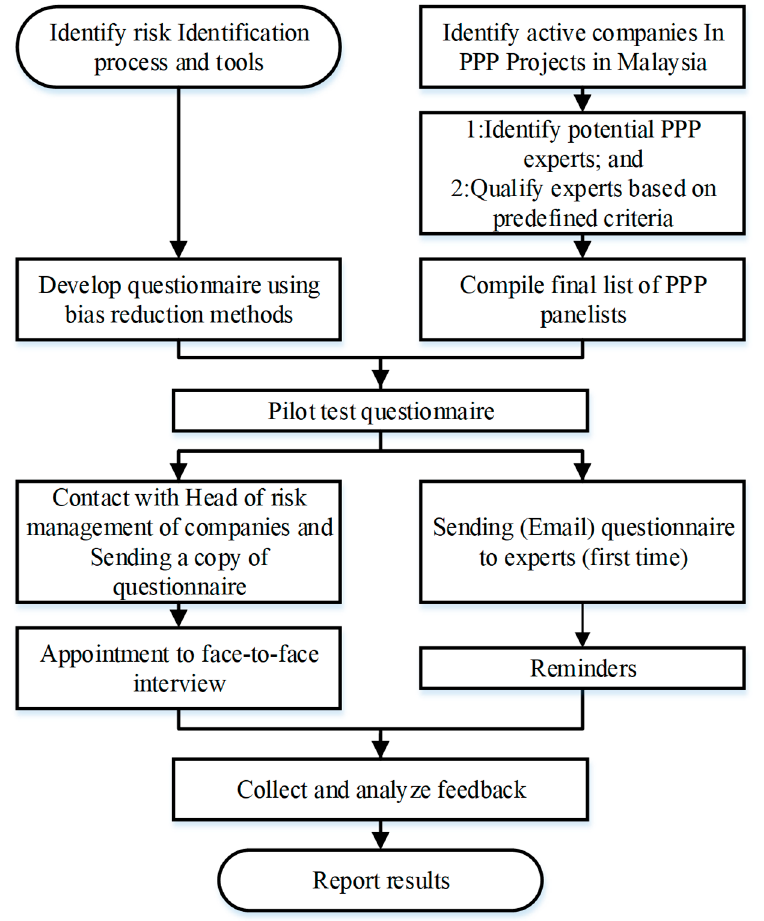
Figure 2. Overall research process. PPP: Public–private partnership.